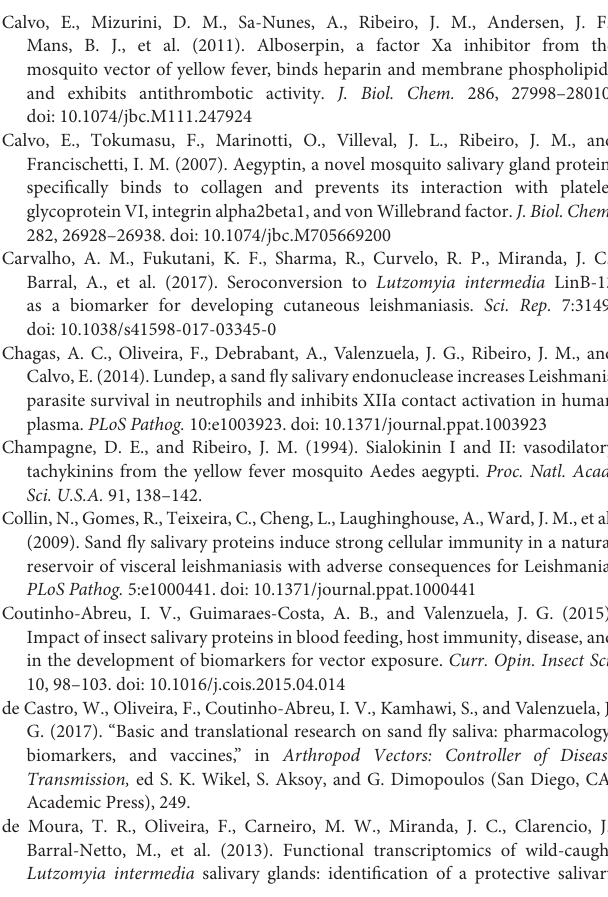
Supplementary Figure 15 | Multiple sequence alignment and molecular phylogenetic analysis of the sand fly small Odorant Binding Protein (OBPs) salivary protein family. (Top) Multiple sequence alignment of OBPs . PPTSP12 and PPTSP14 and PPTSP14.2a and PPTSP15 ( P. papatasi ), PduM12 and PduM60 and PduM07 and PduM50 and PduM57 and PduM31 and PduM49 and PduM58 and PduM62 and PduM99 and PduM02 and PduM03 and PduM06 ( P. duboscqi ), PsSP14 and PsSP14 and PsSP55 and PsSP9 ( P. sergenti ), PtSP9 and PtSP17 and PtSP32 and PtSP31 and PtSP18 and PtSP23 ( P. tobbi ), PpeSP02 and PpeSP09 and PpeSP11 ( P. perniciosus ), PorASP28 and PorASP31 and PorASP37 and PorASP61 and PorASP61 and PorASP64 ( P. orientalis ), ParSP03 and ParSP01 and ParSP08 ( P. ariasi ), PkanSP05 and PkanSP06 and PkanSP07 ( P. kandelakki ), PabSP45 and PabSP2 ( P. ariasi ), PagSP93 and PagSP07 and PagSP01 and PagSP12 and PagSP02 and PagSP13 ( P. argentipes ), LolSOBPa and LolSOBPb and LolSOBPc ( B. olmeca ), Linb-7 and Linb-8 and Linb-28 ( N. intermedia ), LayS69 ( Lu. ayacuchensis ), and LuloOBP ( Lu. longipalpis ). Black background shading represents identical amino acids. Gray background shading represents similar amino acids. Asterisks indicate the conserved cysteine residues. (Bottom) The evolutionary history of OBPs salivary protein family was inferred by using the Maximum Likelihood method based on the Le_Gascuel_2008 model (Gomes et al., 2008). Sand fly species are indicated by the different symbols in the legend on the right. Tree branches were color-coded so as to represent specific taxon: Green color represents the Larroussius and Adlerius subgenera; Red color indicates the Euphlebotomus subgenus; Blue color points to proteins of the Phlebotomus and Paraphlebotomus subgenera; and Black color indicates the proteins belonging to New World sand flies. Supplementary Table 1 | Nucleotide and protein accession